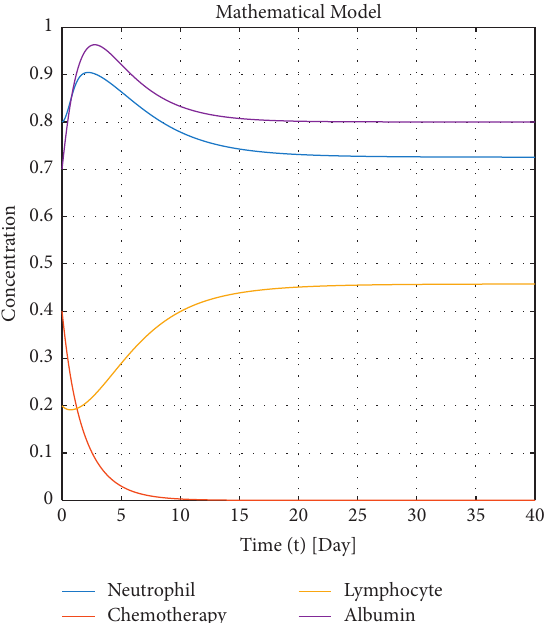
Figure 3: The dynamics of change in N, C, L, and A over time until t � 40 in the first case.